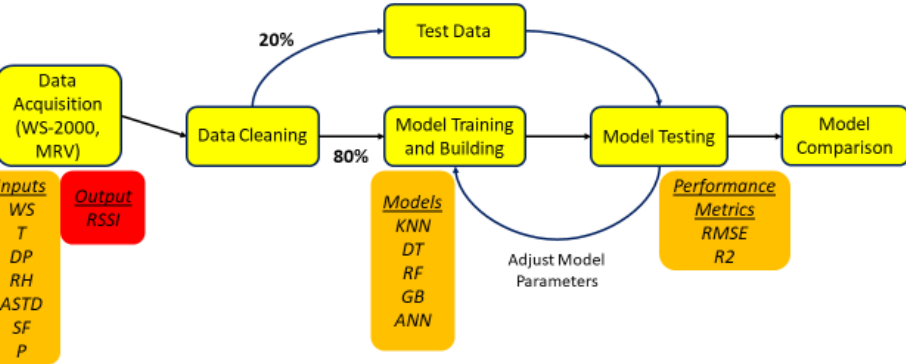
Figure 2. Flow chart diagram for the ML-based methodology for FSO system RSSI modeling. The data analysis was performed using the programming language Python (version